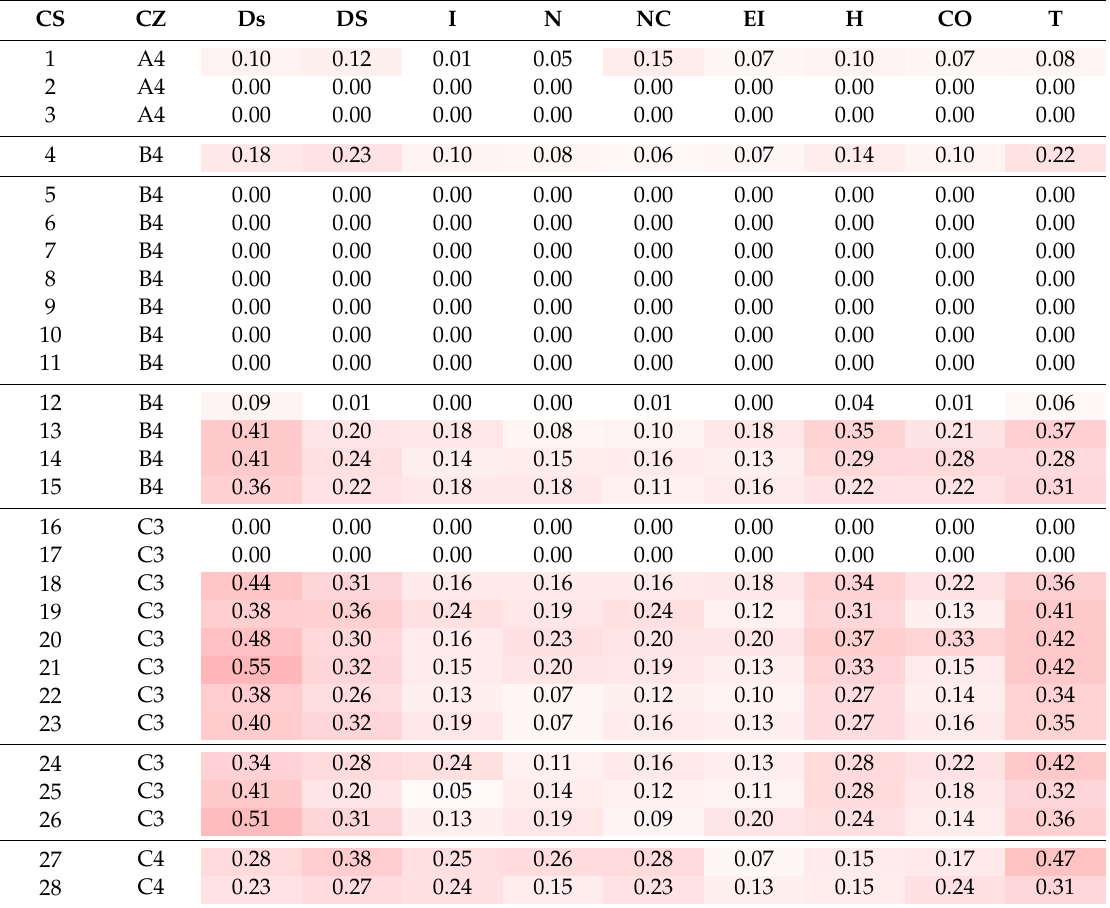
Table 4. Average values of health symptoms in case studies with closed windows. Legend: Case study (CS), Climate zone (CZ), Dizziness (D), Dry Skin (DS), Itchiness (I), Nausea (N), Nasal congestion (NC),